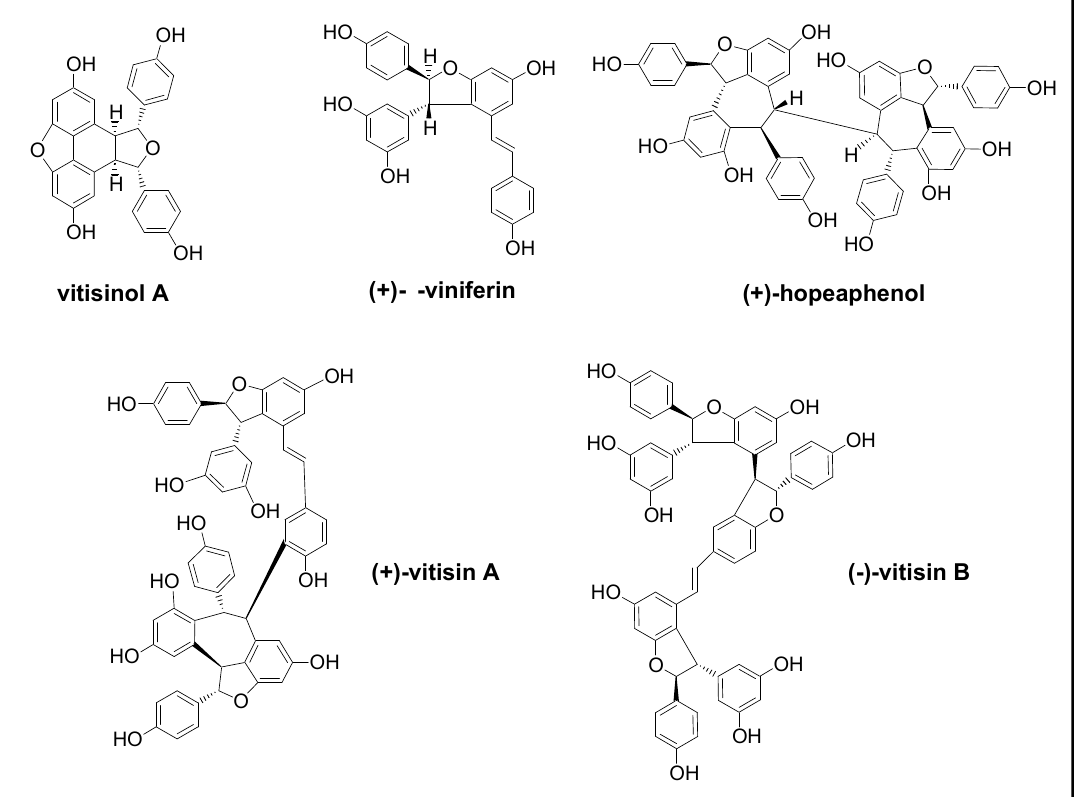
Figure 1. Chemical structures of five oligostilbenes.